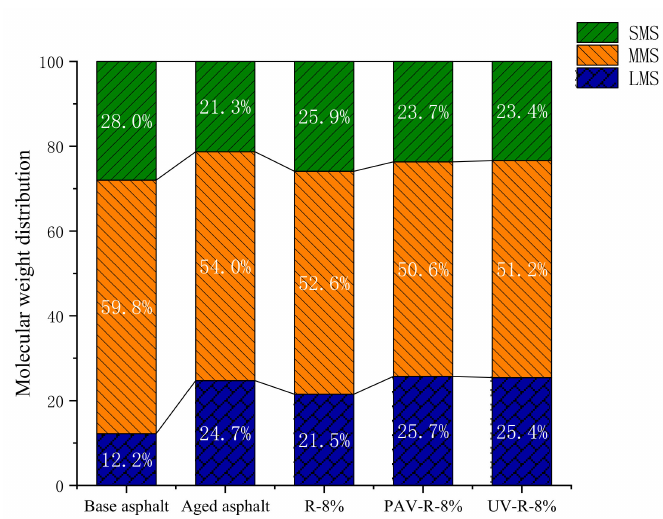
Figure 15. Molecular weight proportion of different